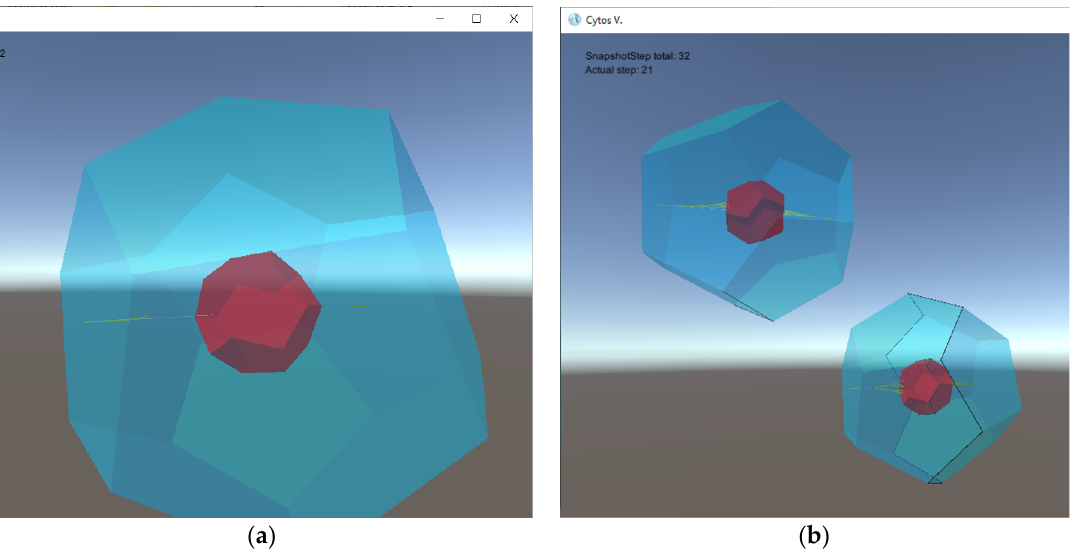
Figure 1. Snapshots of an M system (M 0 ) modeling eukaryotic cell membrane (in blue), cytoskeleton and nuclear membrane (in red) formation ( a ), as well as mitosis ( b ) [18,25].